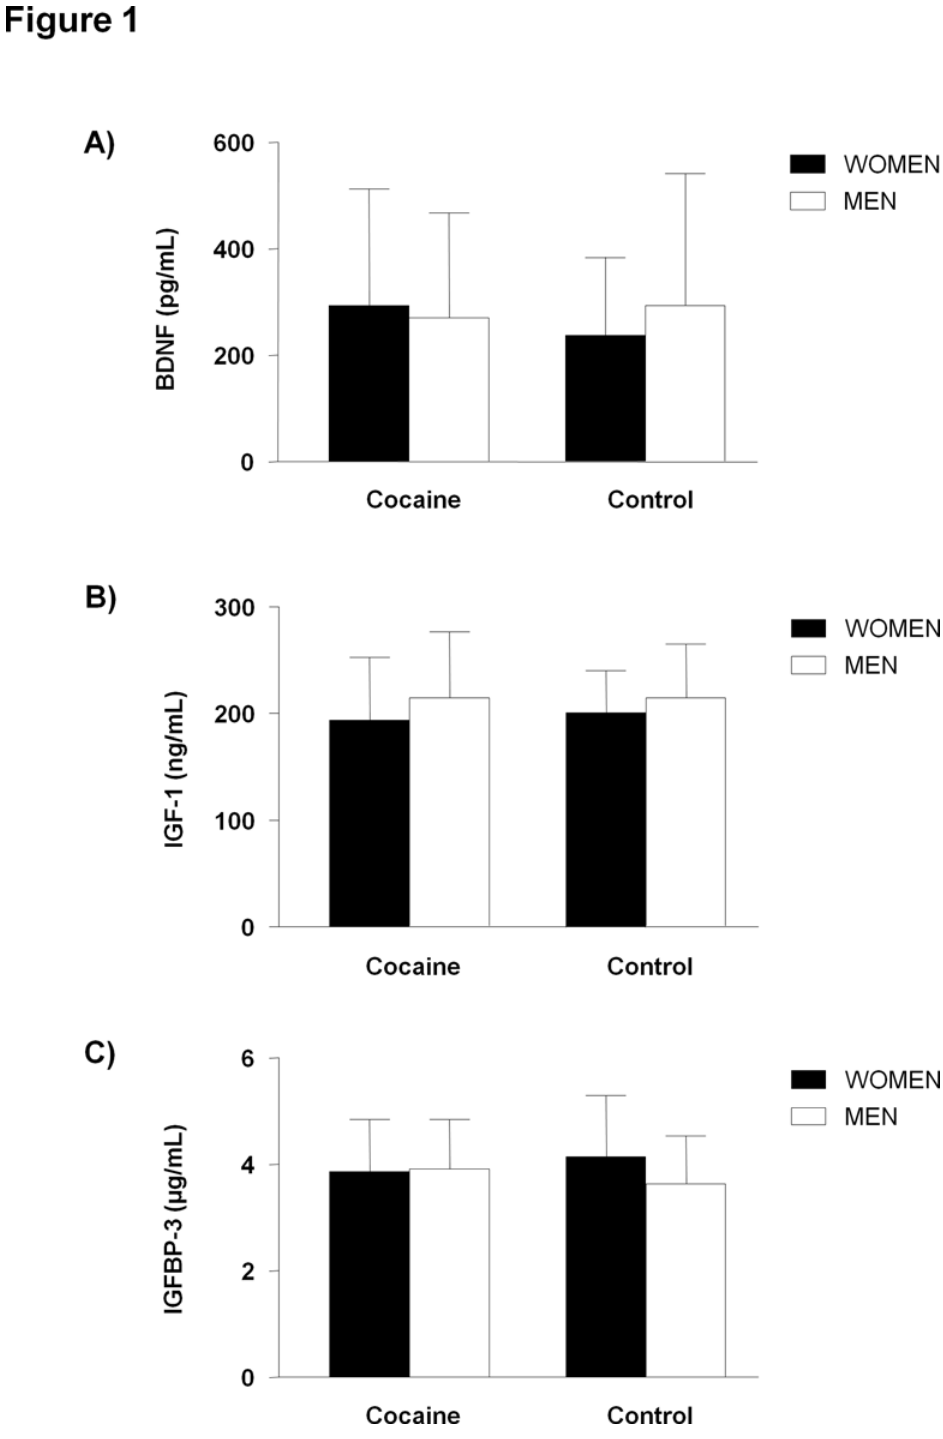
Fig 1. Plasma concentrations of BDNF, IGF-1 and IGFBP-3 according to sex in abstinent cocaine users and control subjects. A) BDNF (pg/mL); B) IGF-1 (ng/mL); and C) IGFBP-3 ( μ g/mL). Bars are the means and SD. Data were analyzed by two-way analyses (cocaine use [cocaine group and control group] and sex [women and men]).